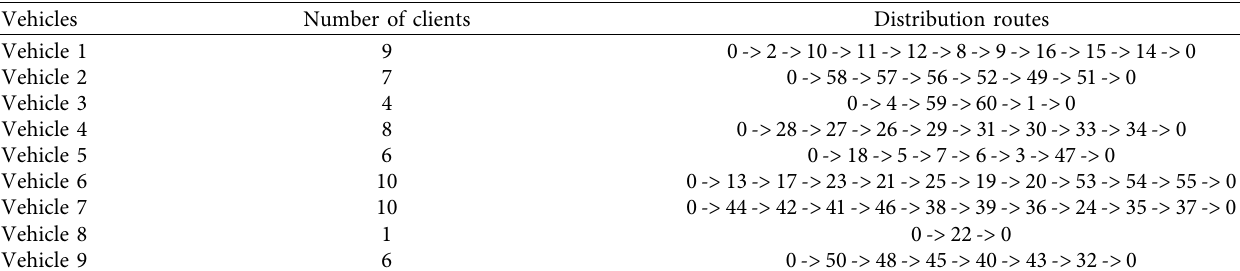
Table 8: Vehicle distribution routes considering the cost of carbon